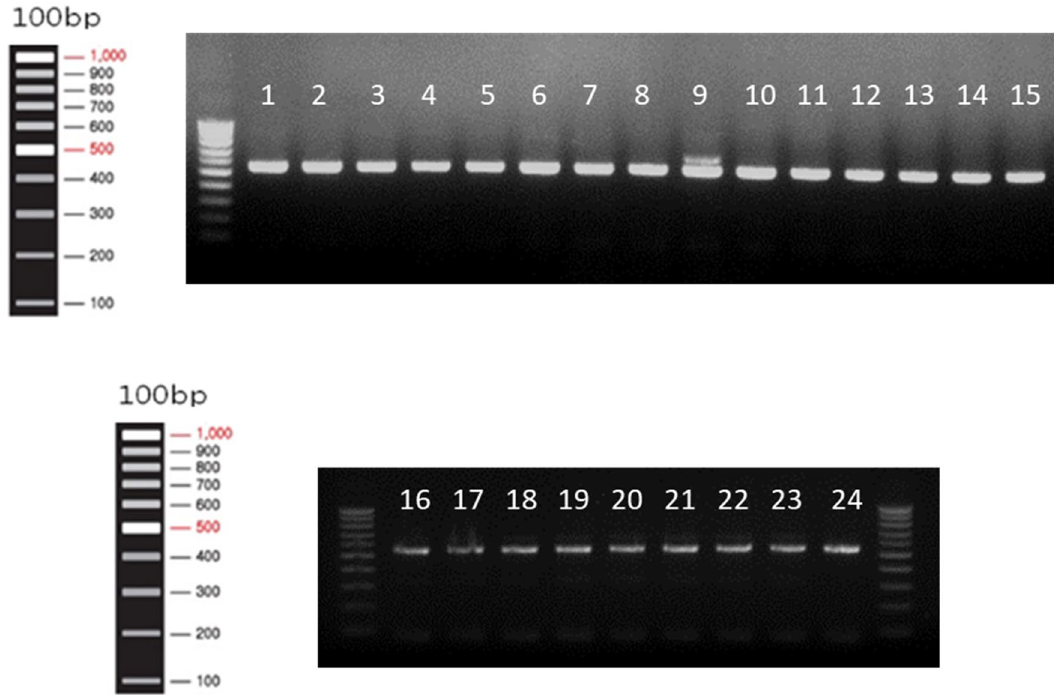
Figure 2. Agarose gel electrophoresis of HSP70 gene. Lane 1–24 are standard for CC type except lane 9. Lane 9 is standard for TC